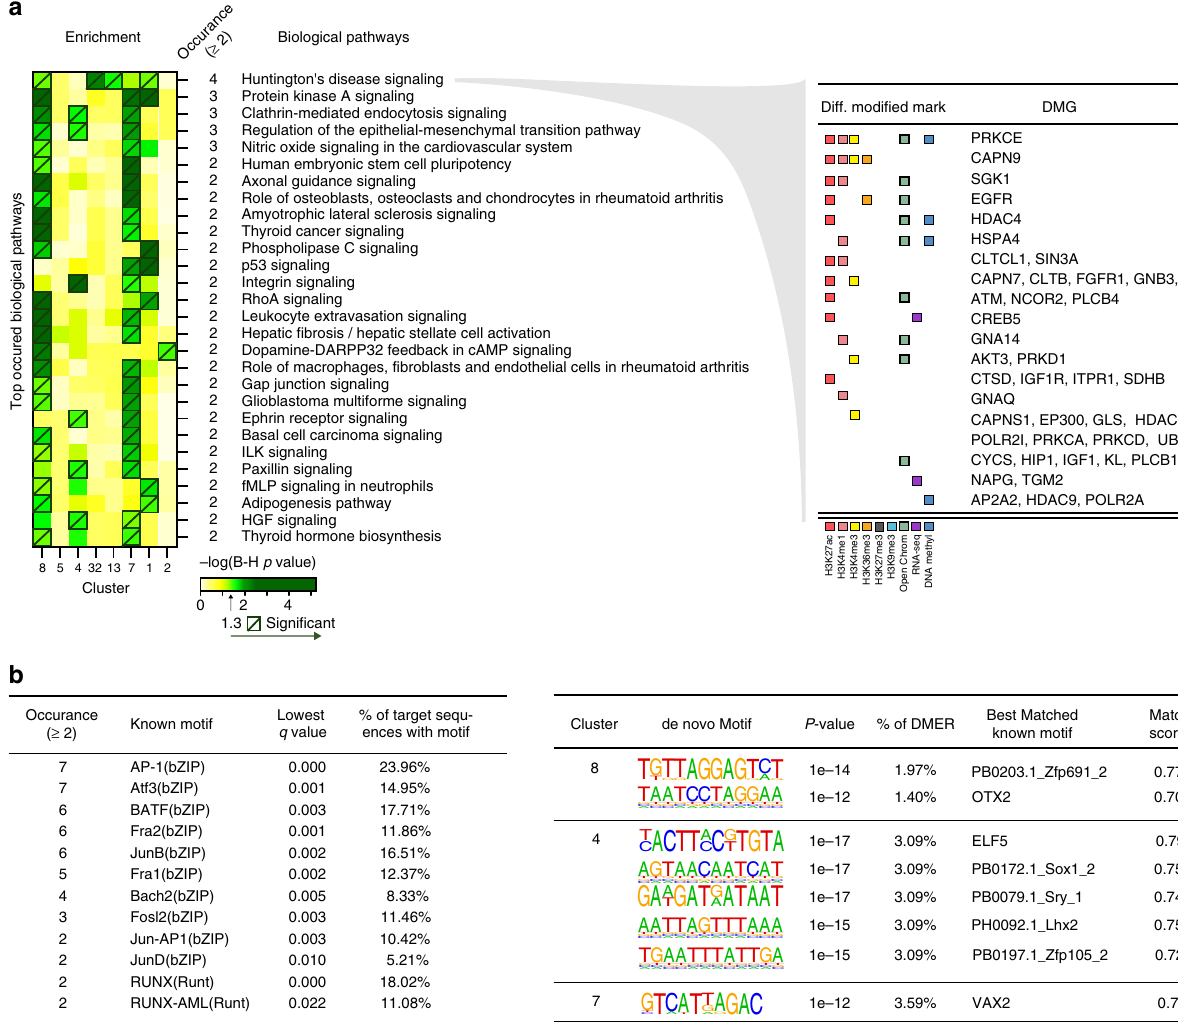
Fig. 4 Prioritized enriched biological pathways and transcription factor (TF) motifs analysis. a Prioritized biological pathways ranked by the number of occurrences in the eight clusters with signi fi cantly enriched pathways (left) and DMGs with associated DMERs in “ Huntington ’ s Disease Signaling ” pathway (right). b Prioritized TF motifs ranked by the frequency in 13 clusters (left). The signi fi cantly enriched de novo TF binding motifs are shown on